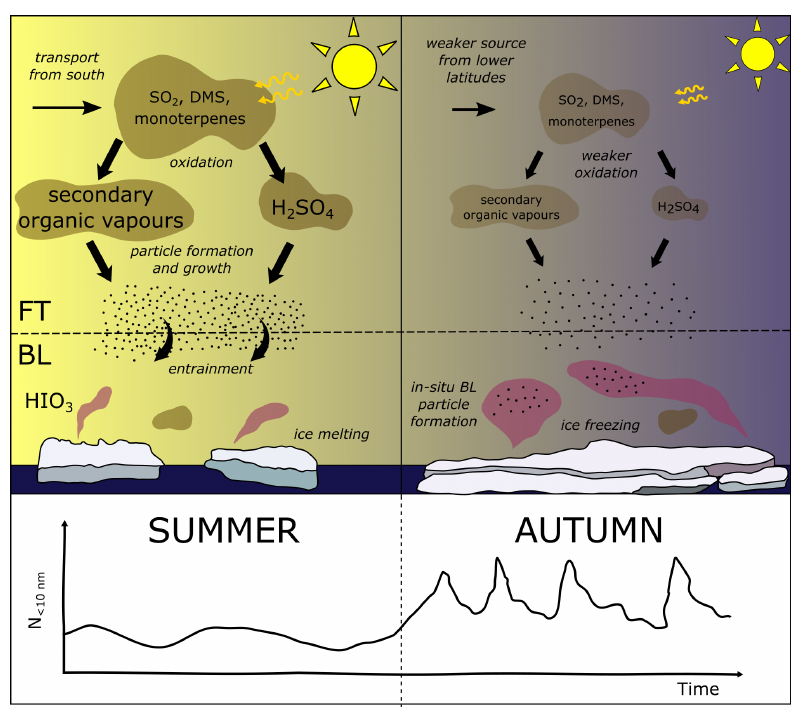
Figure 8. Schematic of processes controlling the concentration of nucleation mode particles at the surface in the high Arctic. The summer sea ice melt period is on the left and the freeze-up period in late summer and early autumn is on the right. A schematic of the nucleation mode particle concentration is shown at the